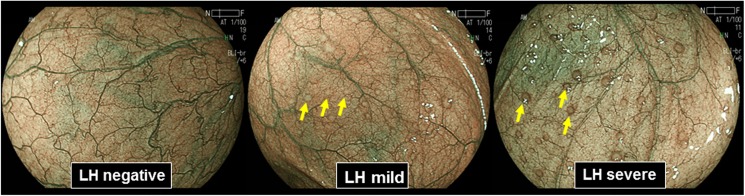
Representative endoscopic findings of lymphoid follicles hyperplasia (LH), observed by the BLI colonoscopy.LH was defined as well demarcated white nodules. Elevated LH with erythema was distinguished as LH high (right). All other LHs were considered as LH mild (center). Yellowish arrows indicates LHs.